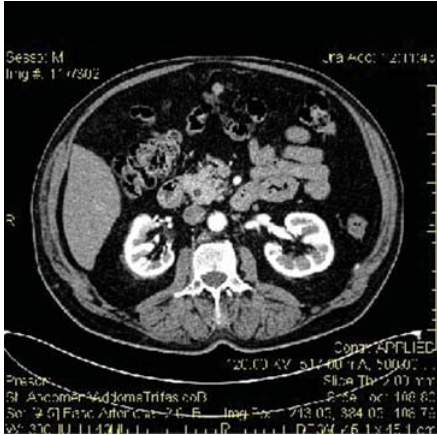
Figure 5: Follow-up CT arterial phase.